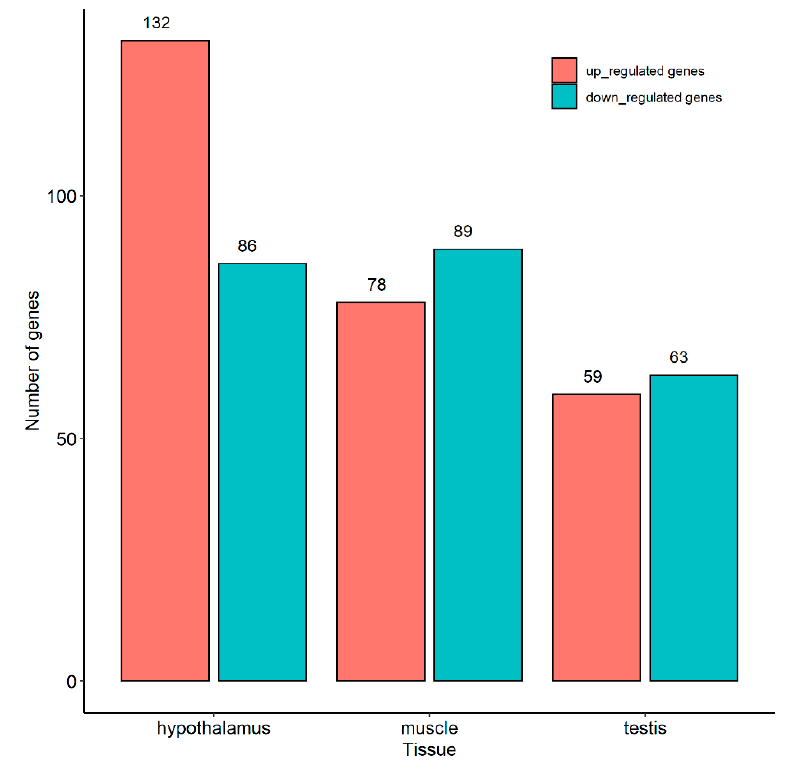
Figure 2. Differentially expressed genes in different